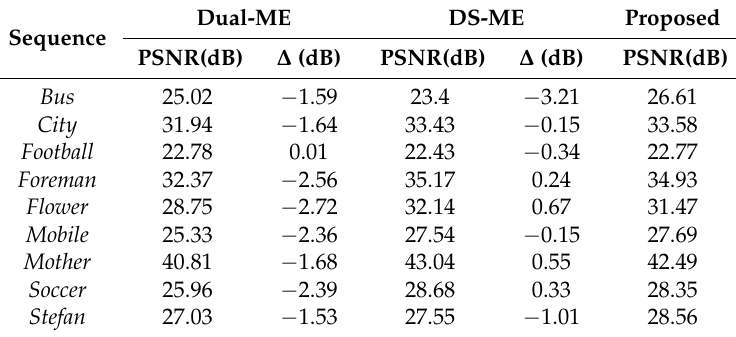
Table 1. Peak Signal-to-Noise Ratio (PSNR) (dB) comparison of different Motion Estimation (ME) methods for the test sequences.